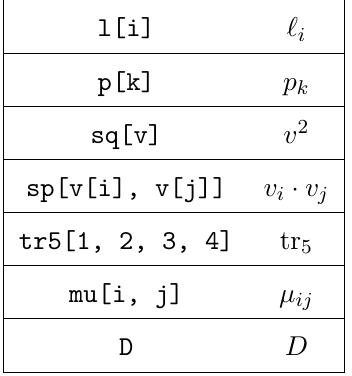
Table 7. Notation used in specifying the numerators of master